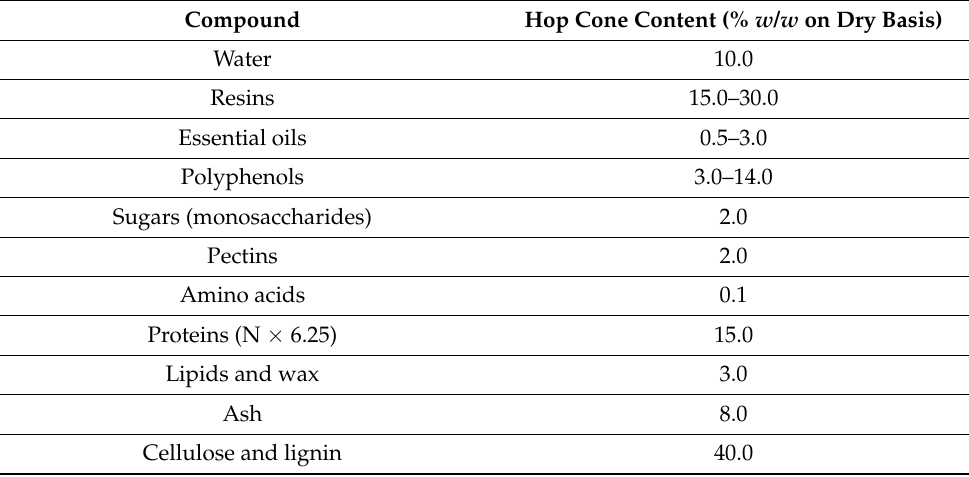
Table 2. Average chemical composition of dried hop